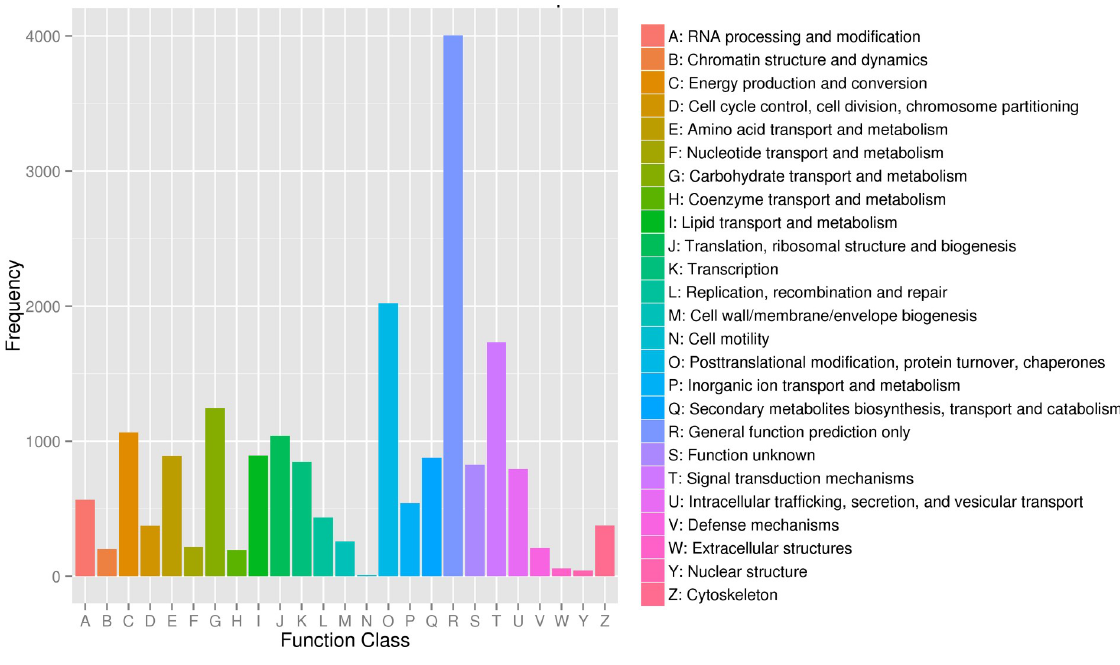
Fig 4. KOG function classification of